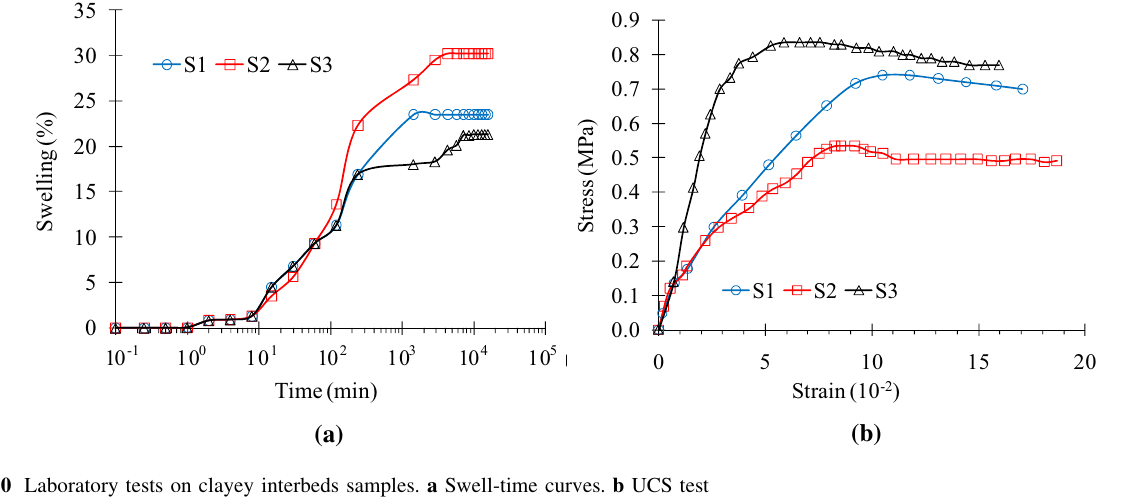
Fig. 10 Laboratory tests on clayey interbeds samples. a Swell-time curves. b UCS test Table 4 Swelling potential in various samples Samples LL PI Swelling Swelling potential (%) (%) (%) Direct methods according to free swelling Holtz and Gibbs [25] Chen